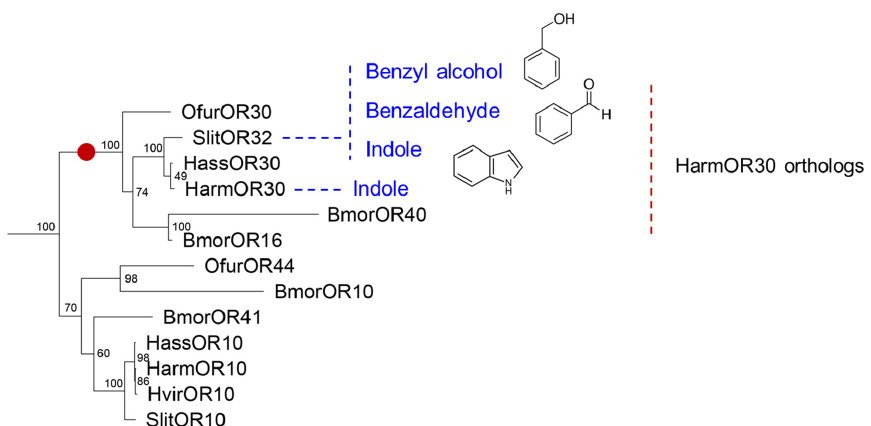
Figure 2. The orthologous clade of HarmOR30 from the phylogenetic tree of six lepidopteran species. The clade of HarmOR30 orthologs was marked with a red dot on the branch. Clade nodes values representing the bootstrap values were shown from 49 to 100. The ligands of functional identified ORs were shown on the right of ORs with an indigo font. H. armigera , Harm; S. littoralis , Slit; O. furnicalis , Ofur; H. assulta , Hass; B. mori , Bmor; H. virescens , Hvir.